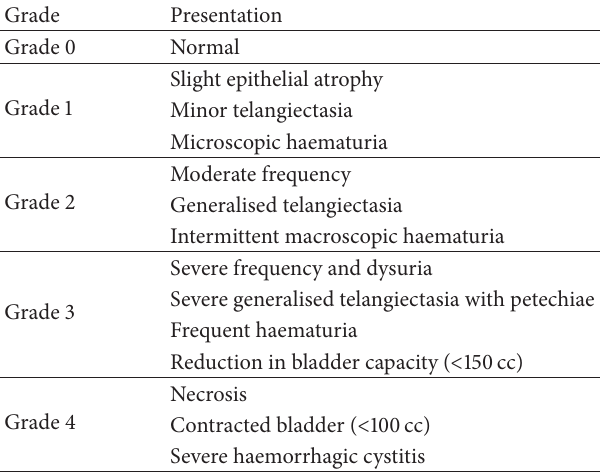
Table 2: Radiation Therapy Oncology Group Late Radiation Mor- bidity Scoring Schema [11].